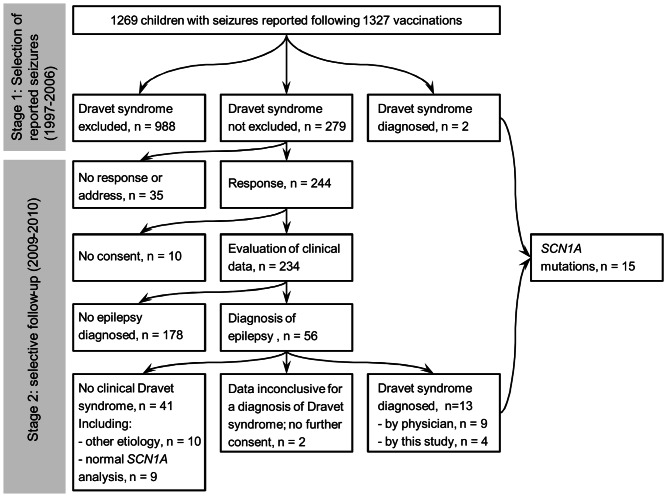
Design of study.